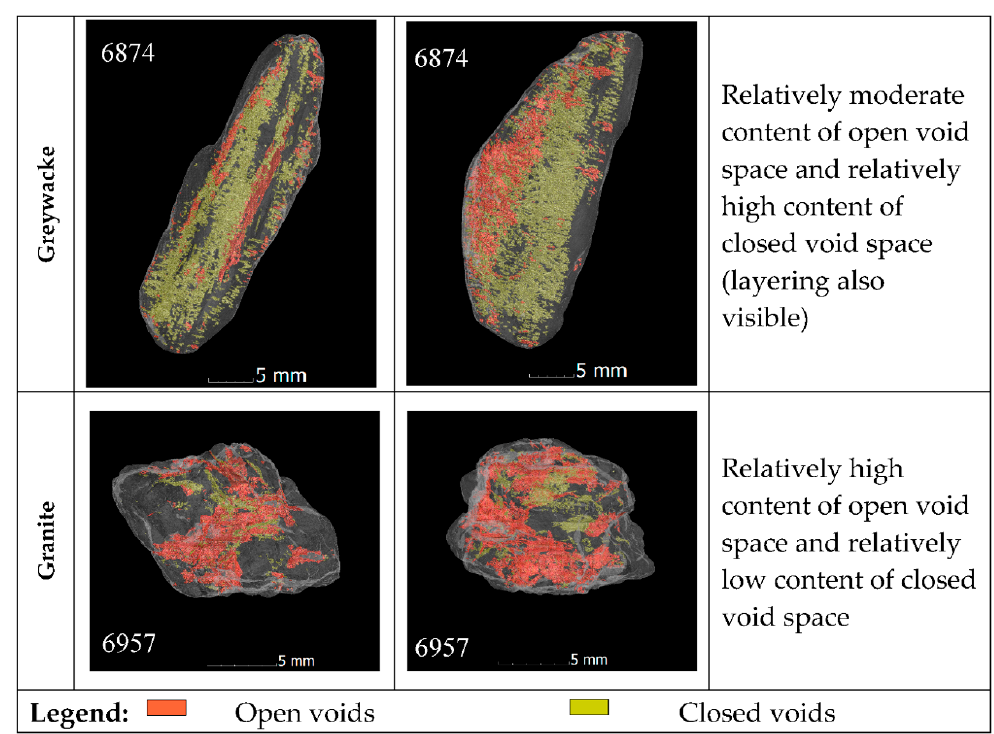
Figure A2. CT-visualizations for individual river gravel aggregate of type GK4 (the left and right images for each aggregate show views from the 0 and 90 degrees, respectively) (based on figures in [10,11]).